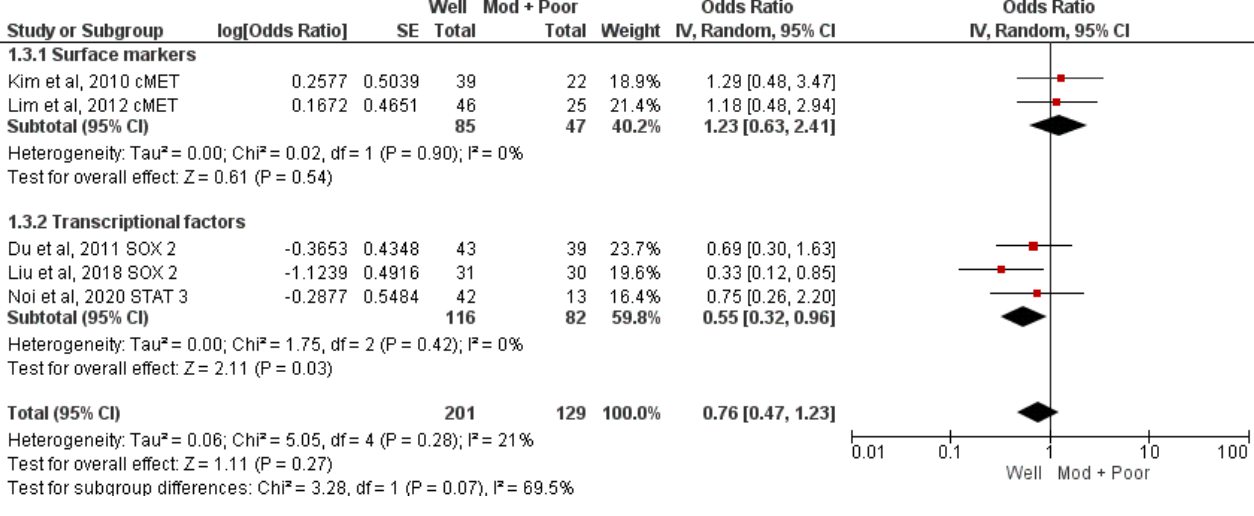
Figure 3. Meta-analysis of CSC markers and histological grading [29–33].